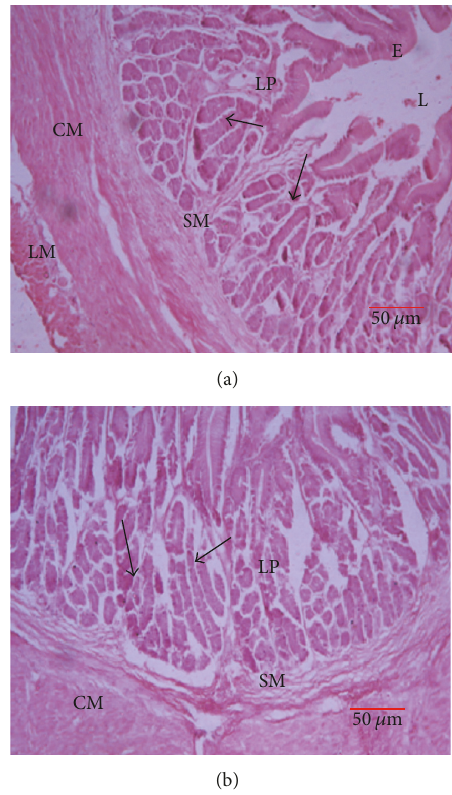
Figure 7: Transverse section through the stomach. (a) Cardiac stomach and (b) fundic stomach: lumen (L), epithelium (E), sub- mucosa (SM), lamina propria (LP), circular muscle layer (CM), and longitudinal muscle